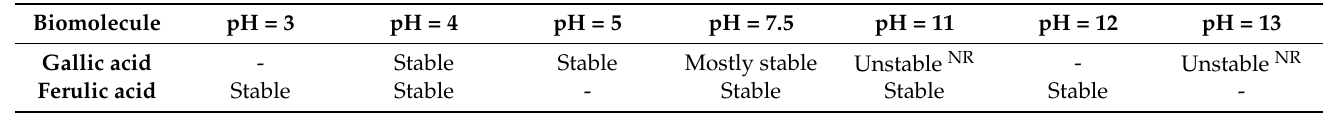
Table 4. Experimental phase mass ( 𝑚 ), biomolecule mass losses ( 𝐿 m ), biomolecule concentration ( 𝐶 ), phase density ( 𝜌 ) and phase pH for the top and bottom phases in the extraction of gallic acid or ferulic acid in the ATPS {ethyl lactate (1) + trisodium citrate or tripotassium citrate (2) + water (3)} at 298.15 K and 0.1 MPa b .